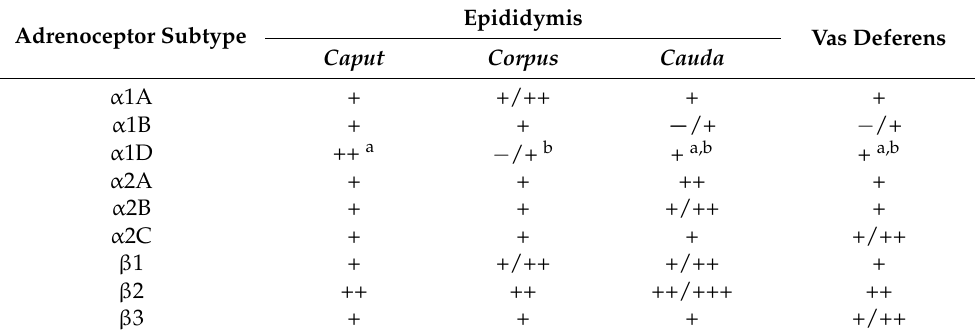
Table 2. The semiquantitative assessment of the intensity of reaction in the epithelium of epididymal tubuli/vas deferens in domestic cats. The data are presented as the median score of the intensity of immunostaining ( n =